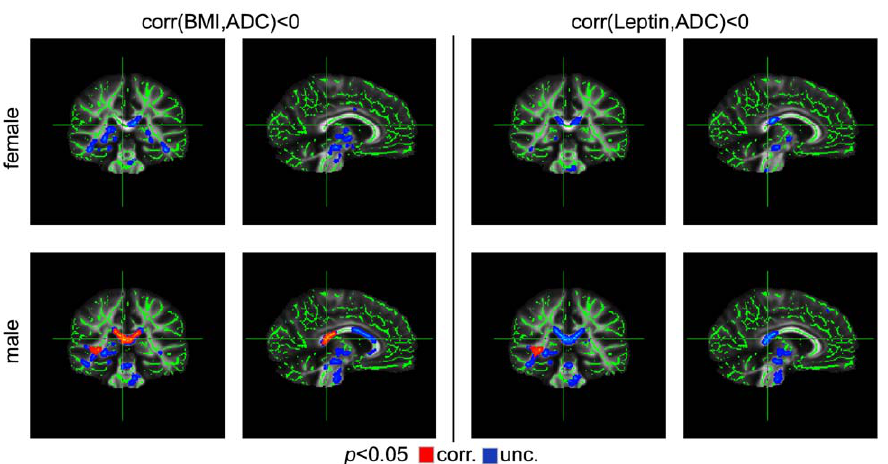
Figure 5. Correlation between ADC and body weight using BMI (left) and leptin levels (right). We found a significant negative correlation between BMI and ADC for men in the splenium of the corpus callosum. Using leptin levels instead of BMI, this correlation was only present without correction for multiple comparisons.